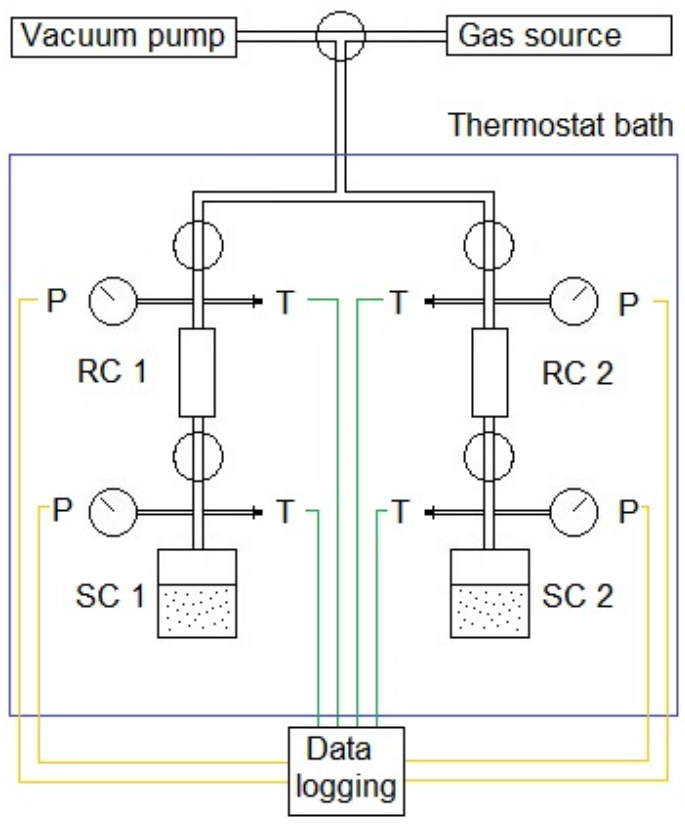
Figure 4. Scheme of laboratory sorption setup used in the study (SC—sample cell; RC—reference cell). After determining the volume of the measuring cell, the setup was vacuumed and filled with carbon dioxide. After filling the reference cell and stabilization of conditions, the valve between the reference cell and the sample cell was opened and carbon dioxide was passed into the tank with the tested sample. The physical sorption process then occurred on the surface of the samples. A pressure drop was observed over time and when the equilibrium was reached the sorption rate could be calculated. The highest sorption rate occurred in the first minutes of the test, while determination of the full sorption capacity took up to a few hours. The next step of closing the sample cell valve, raising the gas pressure in the reference cell, stabilizing conditions and opening the valve, and then letting the next portion of gas flow into the sample cell, was conducted one day after the previous step. A total number of 5 steps were conducted up to the pressure of 10 MPa. The same test procedure was conducted for methane. The gas injection procedure is shown in Figure 5. Reference cell volumes were determined for each line of the setup, and were 151.382 cm 3 and 154.039 cm 3 , respectively. The mass of adsorbent (pyrolyzed spruce wood) placed in the sample cell was 73.5 g and 59.7 g in line 1 and 2 of the setup,